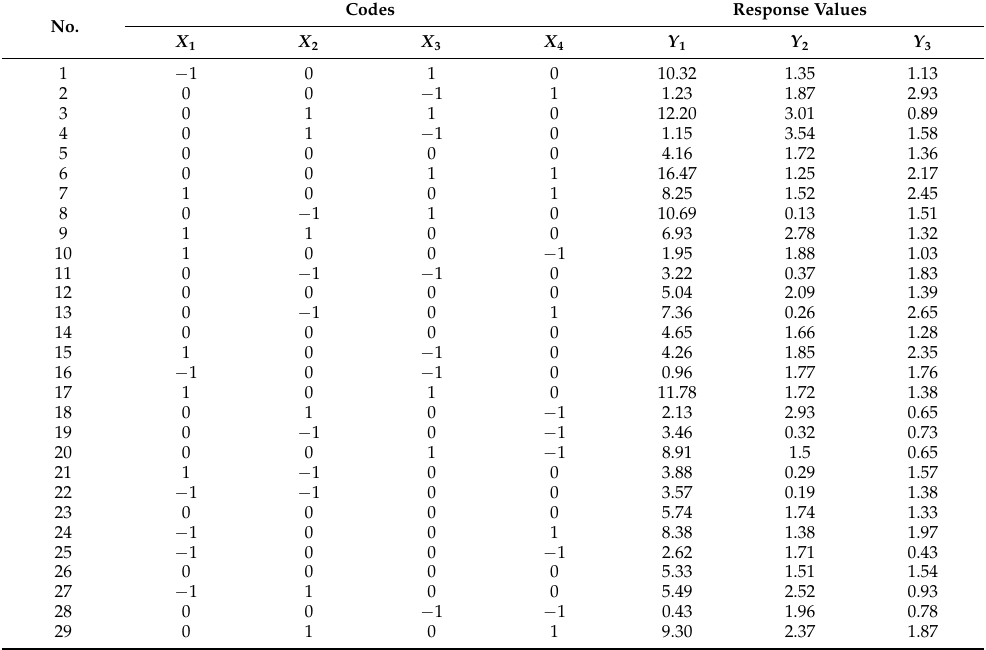
Table 5. Experiment design and response